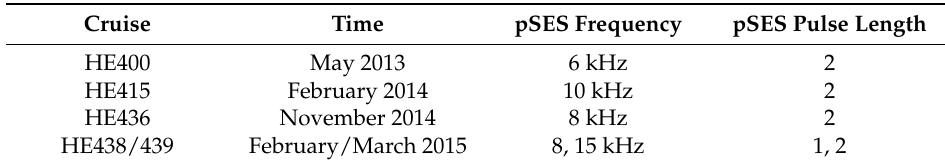
Table 1. List of cruises with RV Heincke between 2013 and 2015 and the corresponding parametric sediment echo sounder settings (pSES). Cruise Time pSES Frequency pSES Pulse Length HE400 May 2013 6 kHz 2 HE415 February 2014 10 kHz 2 HE436 November 2014 8 kHz 2